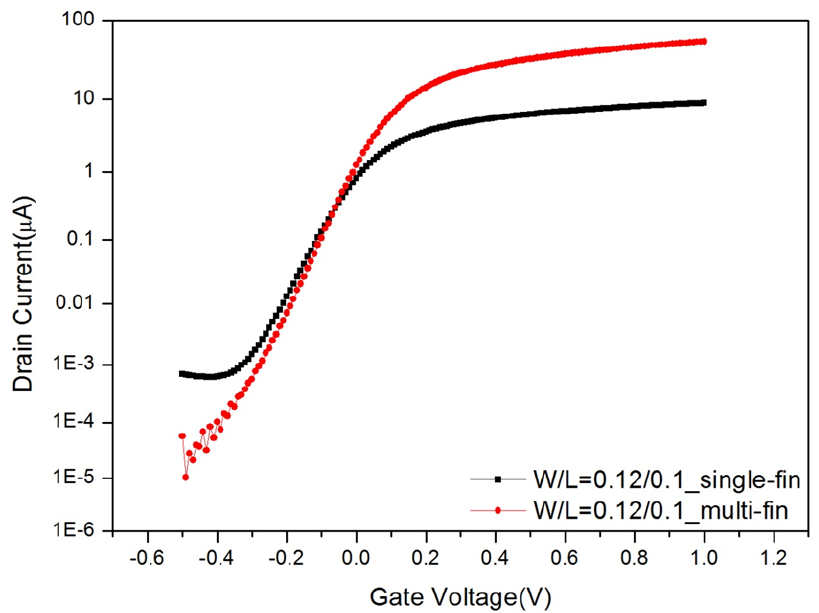
Figure 11. Electrical characteristics of I DS vs. V GS for single and multi-fin n-channel FinFETs as W / L = 0.12/0.1 ( µ m/ µ m) at V DS = 0.05 V.